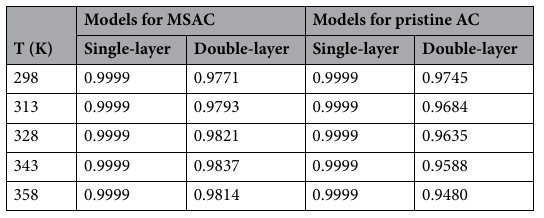
Table 3. Coefficient of determination (R 2 ) for different statistical physics models for MSAC and pristine activated carbon.